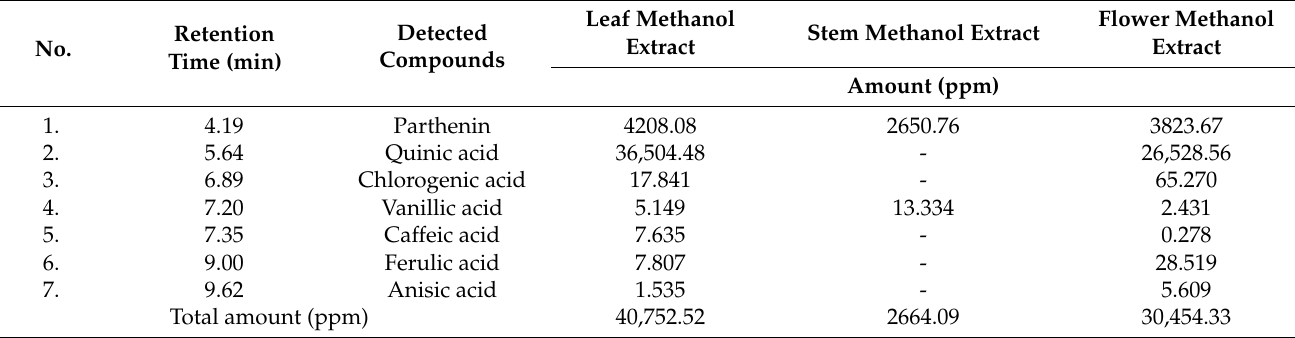
Table 2. Major phytotoxic compounds and their quantity (ppm) detected from aerial parts extracts of P. hysterophorus.